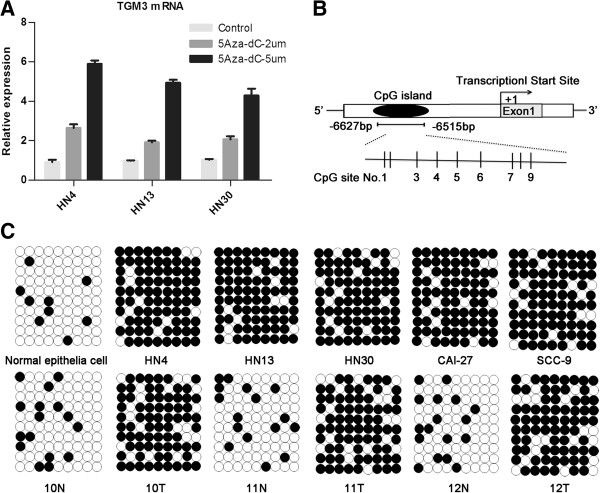
Promoter region hypermethylation mediated the silencing of TGM3 in HNSCC. (A) Restoration of TGM3 expression by 5-Aza-dC. Three representative HNSCC cell lines were treated with 2 μM or 5 μM 5-Aza-dC for 5 days, and TGM3 transcriptional levels were determined by real-time RT-PCR. (B) Schematic representations of the location of the CpG islands in the upstream region of the TGM3 gene and the location of bisulfate-based sequencing within the CpG island. (C) Bisulfate-treated genomic DNA sequencing to detect the methylation status of the CpG islands in 5 HNSCC cell lines and 3 representative HNSCC samples compared with the methylation status in normal primary head and neck epithelial cells and paired adjacent normal tissues. White and black circles represent unmethylated and methylated CpGs, respectively.